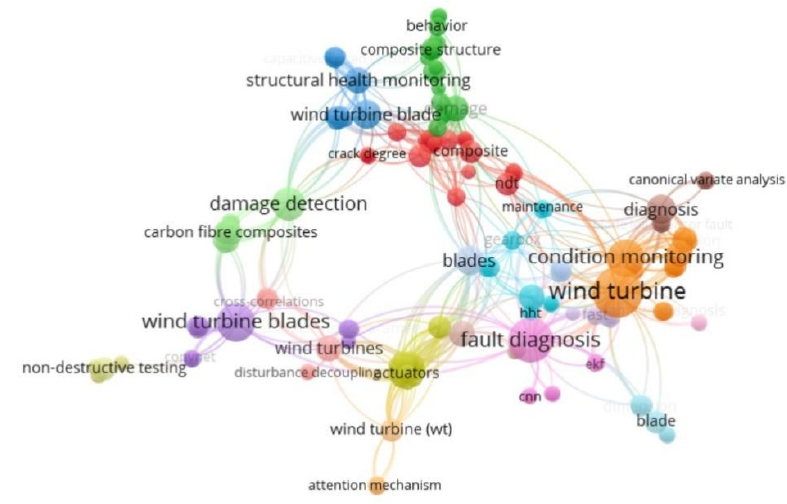
Figure 6. Keywords cluster of wind turbine blade fault diagnosis method.